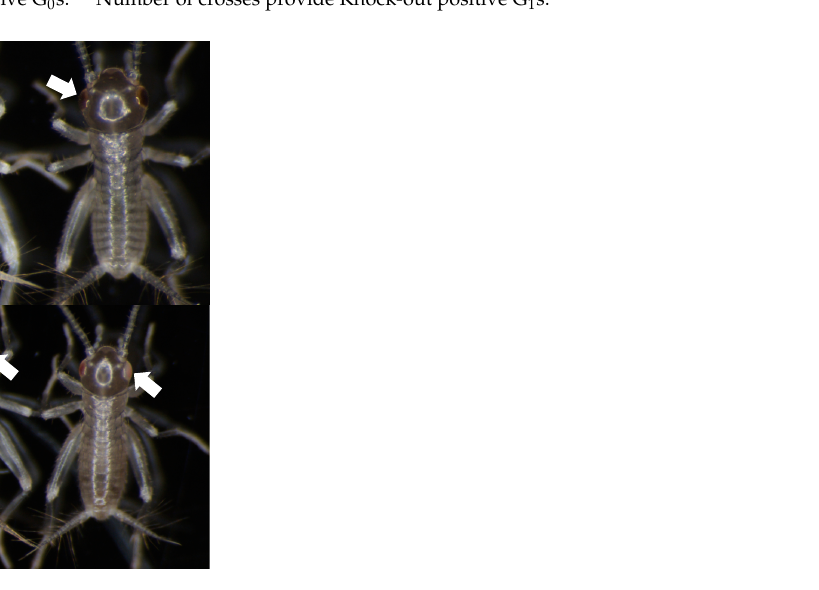
Figure 6. Vermilion eye color phenotype in A. domesticus . ( A ) wild-type eye color in freshly hatched cricket (left) and few hours old cricket (right). ( B ) Eye color of completely knocked-out Ad vermilion gene (left) and cricket with partial knock-out phenotype (right). The white arrows point out the location of the cricket eyes where the respective phenotypes can be observed. Table 4. Deletions from CRISPR knock-out strains in A. domesticus